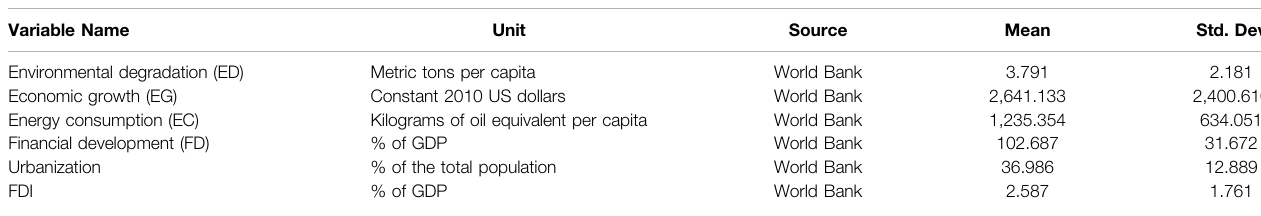
TABLE 1 | Summary